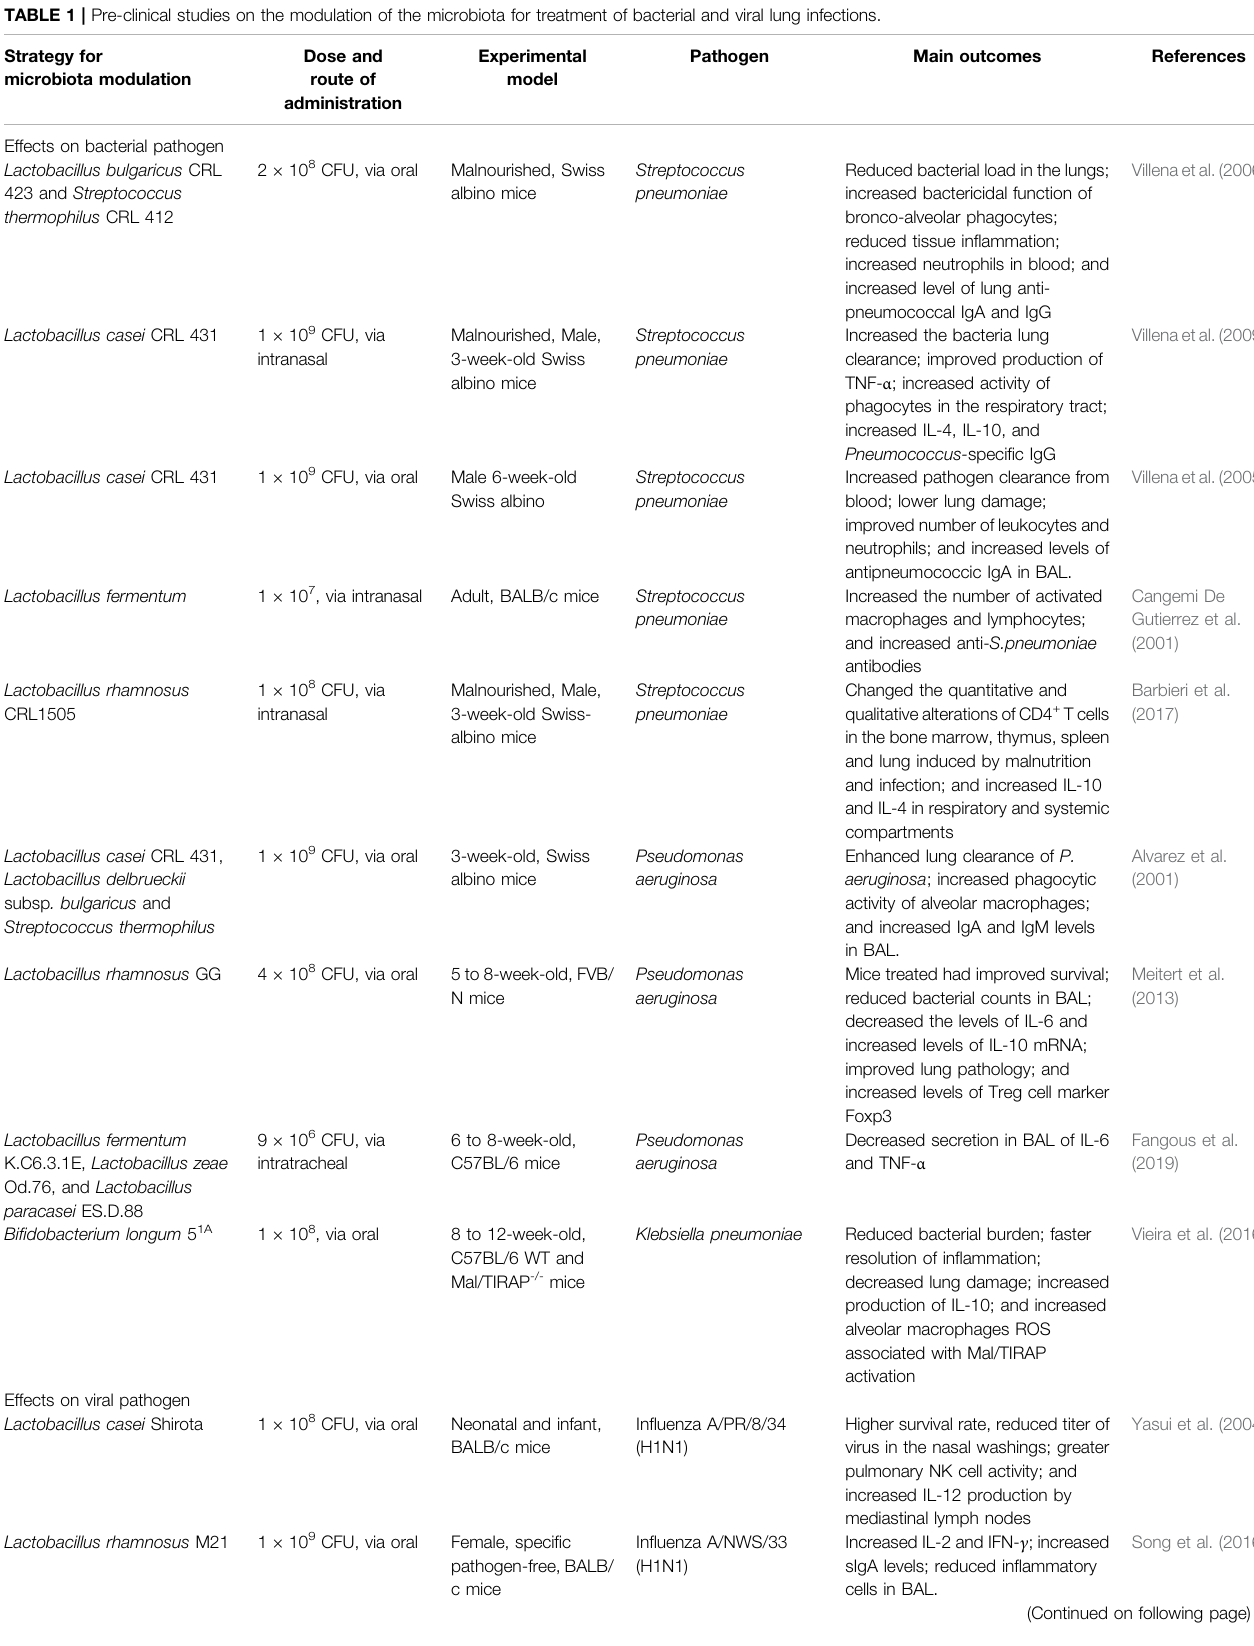
TABLE 1 | Pre-clinical studies on the modulation of the microbiota for treatment of bacterial and viral lung